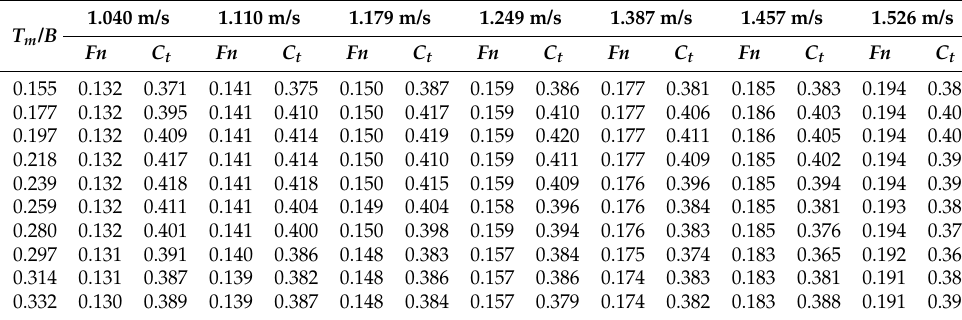
Table 5. Model ship resistance coefficient at different Fn and T m /B .